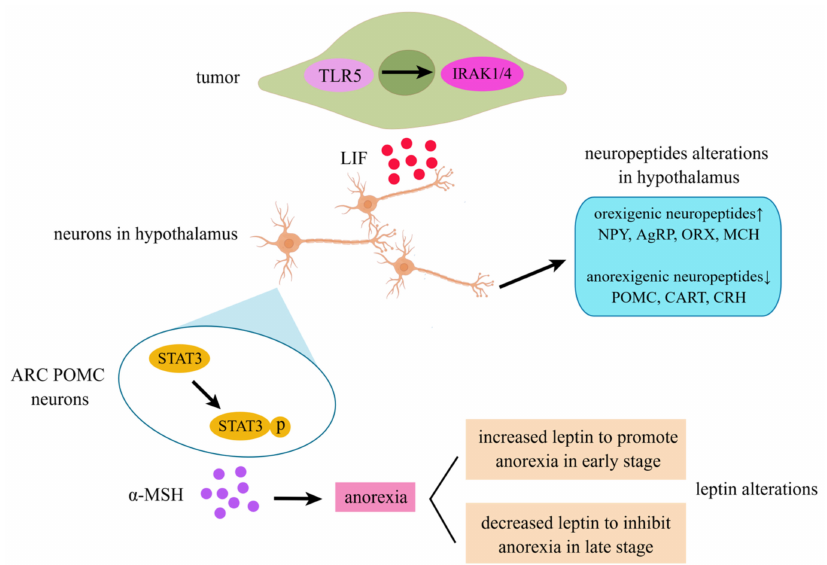
Figure 3. LIF-induced anorexia in cancer cachexia. TLR5 can activate IRAK1/4 to promote LIF secretion in tumors. LIF can facilitate α -MSH secretion from ARC POMC neurons in the hypotha- lamus that are associated with elevated STAT3 phosphorylation. Additionally, up-regulated LIF is associated with increased orexigenic neuropeptides (NPY, AgRP, ORX, and MCH) and decreased anorexigenic neuropeptides (POMC, CART, and CRH) in the hypothalamus. Leptin increases in the early stage to promote anorexia and decreases in the late stage to inhibit anorexia (by Figdraw, “www.figdraw.com”, accessed on 28 May